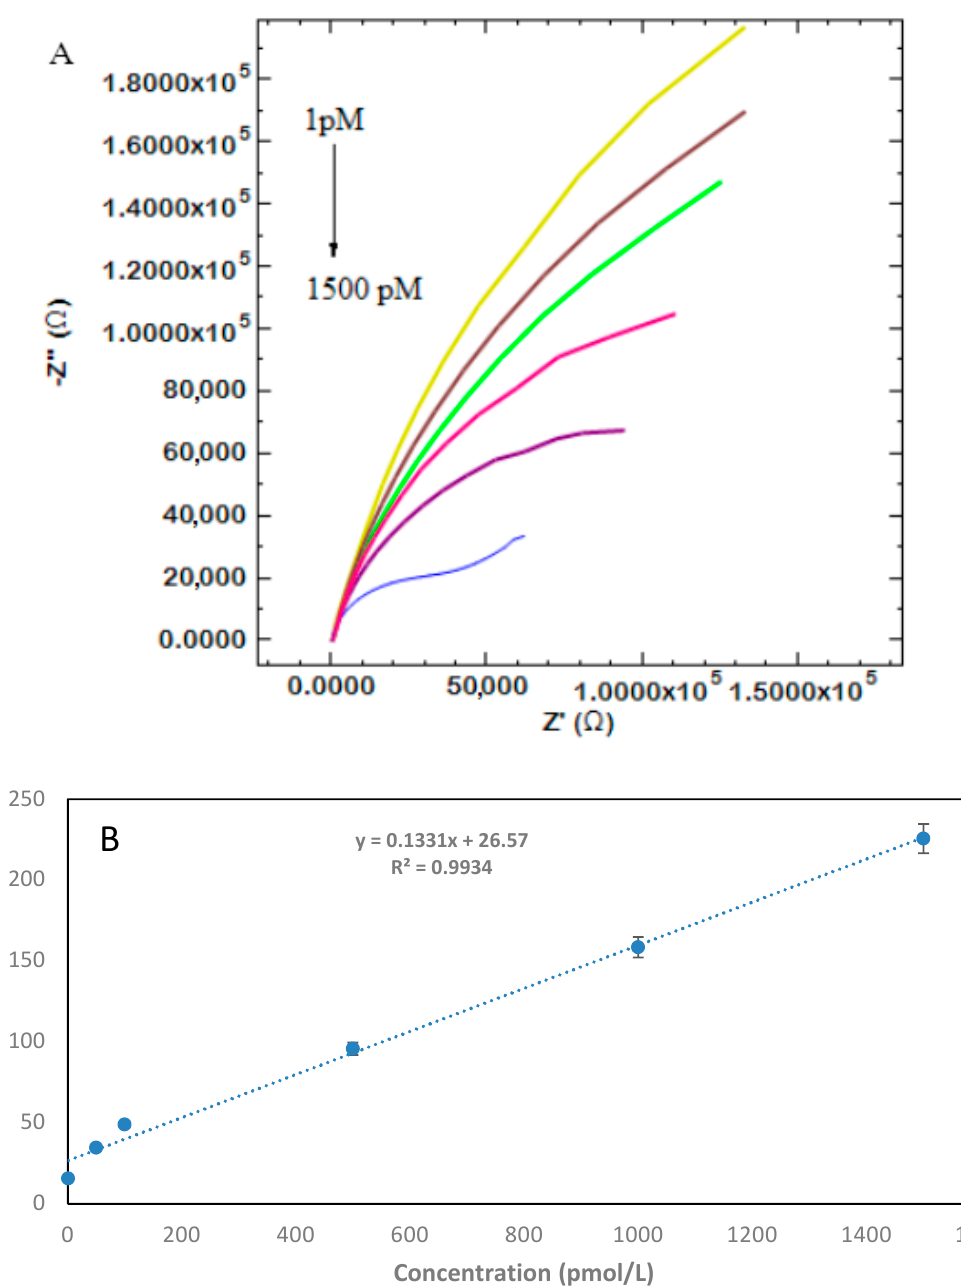
Figure 4. ( A ) Impedance spectra (Nyquist plots) of the developed CDs / SPCE aptasensor for di ff erent concentrations of E2. ( B ) Linear plots between concentration of E2 and relative impedance change Figure 4